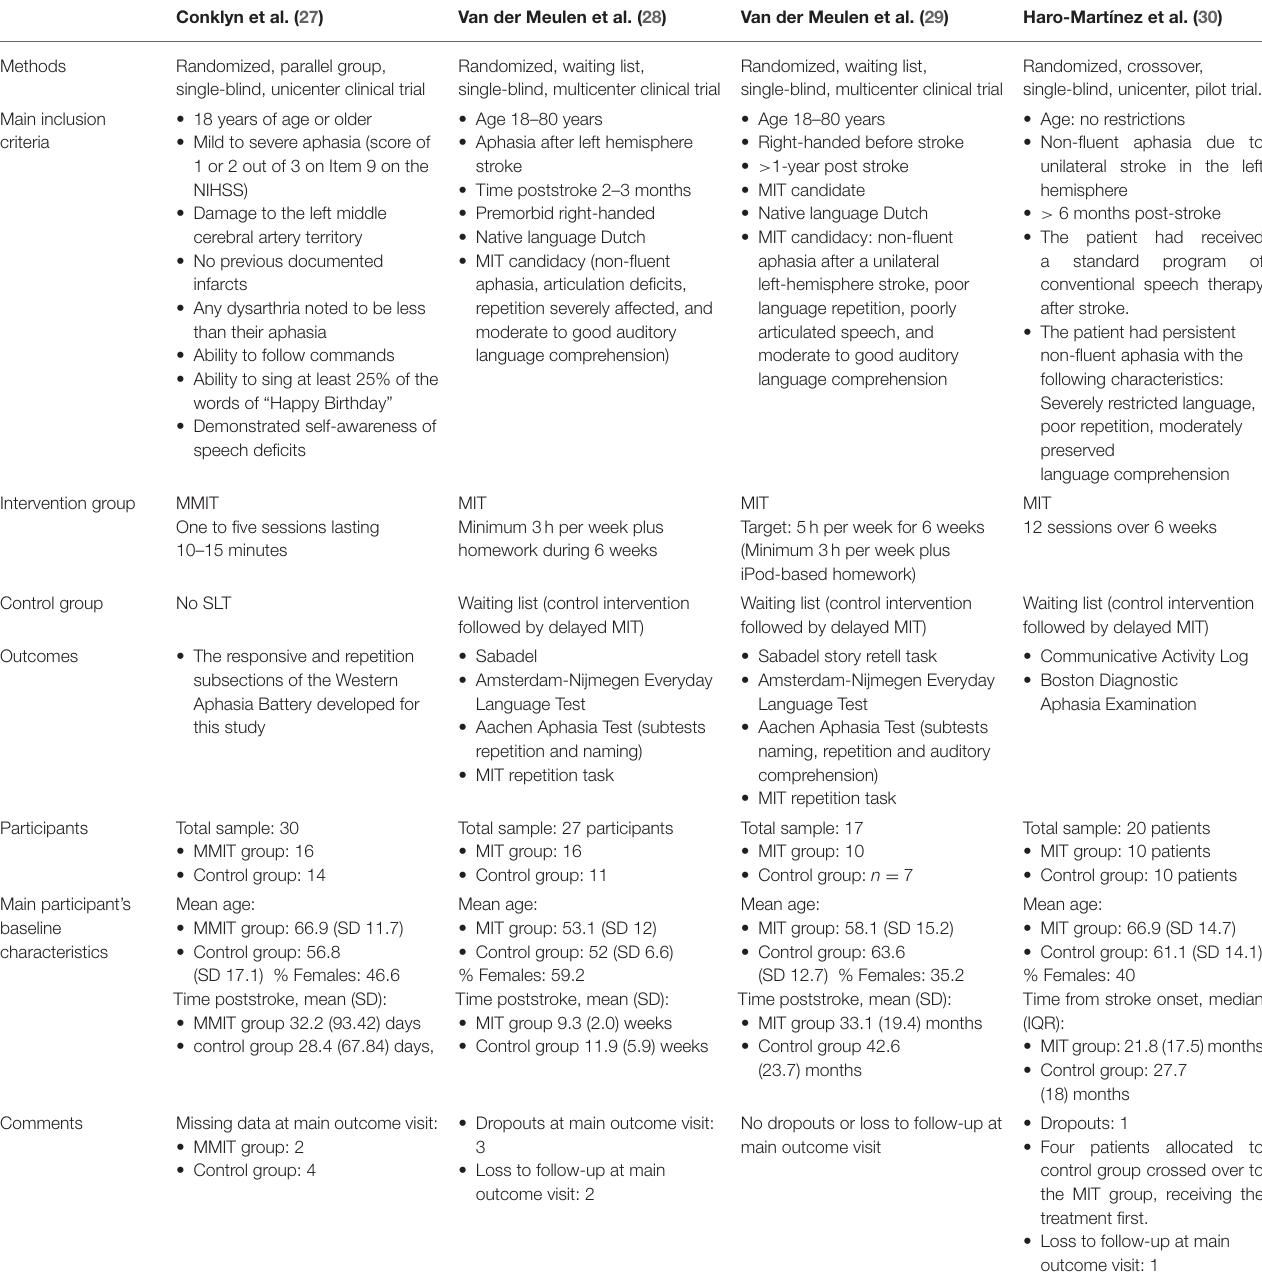
TABLE 1 | Main characteristics of included